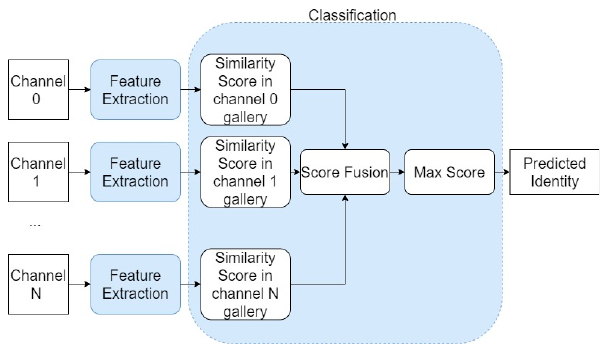
Figure 5. Schematic of the Face Recognition Module.